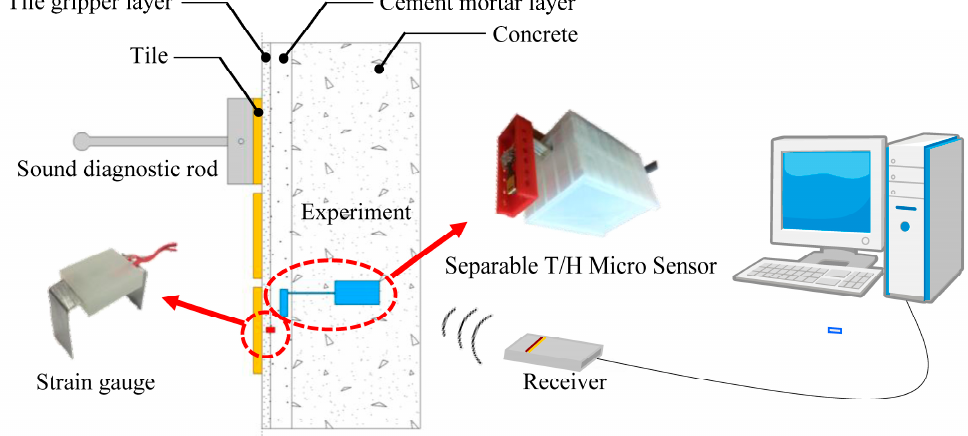
Figure 3. Design concept and structure of the external wall simulation specimen.